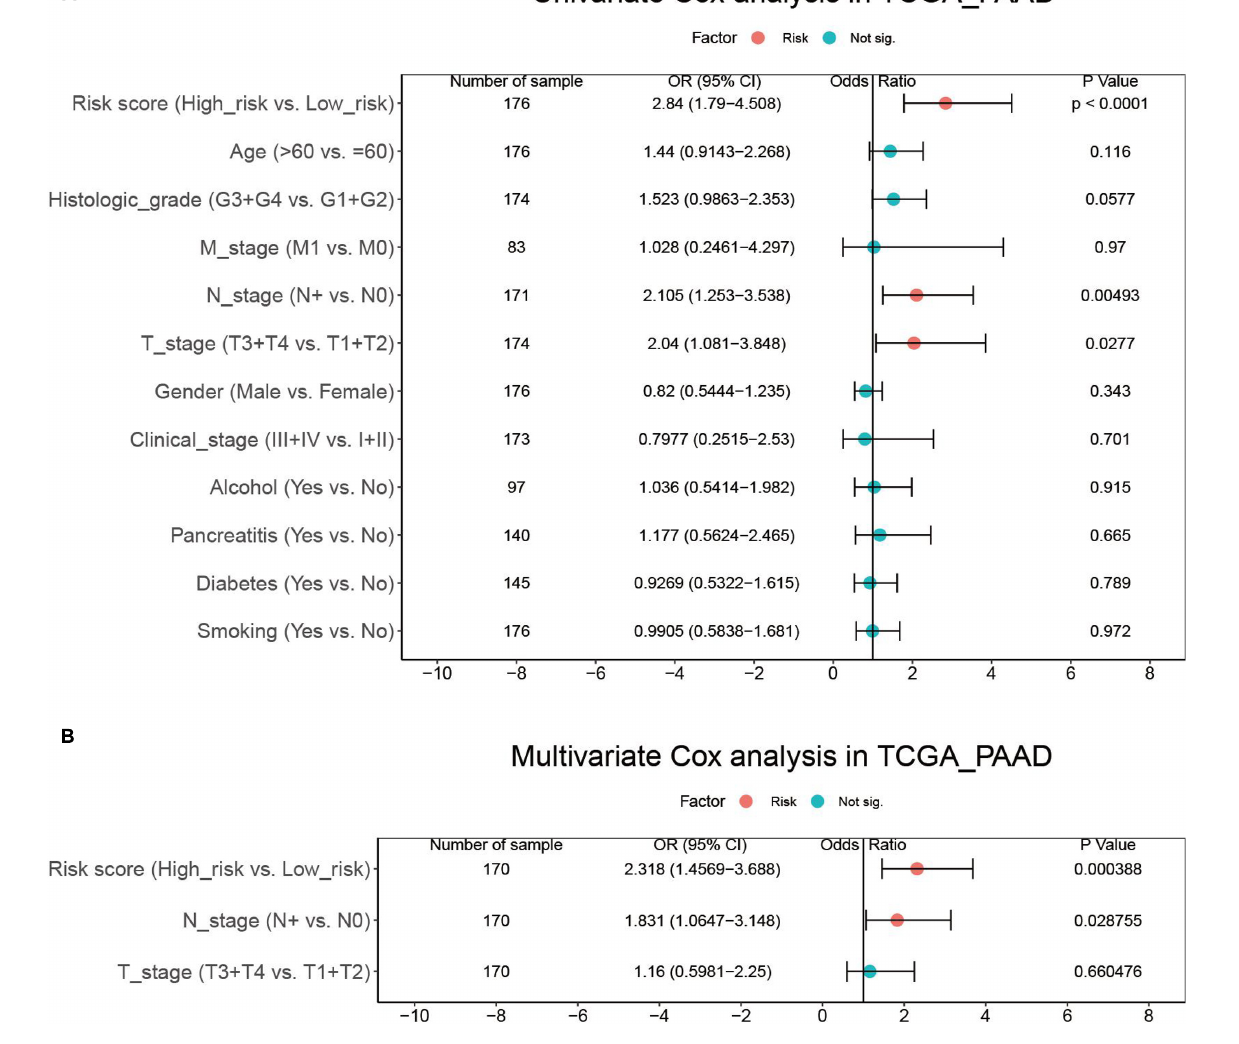
FIGURE 6 | Results of the univariate (A) and multivariate (B) Cox regression analyses regarding OS in the TCGA_PAAD